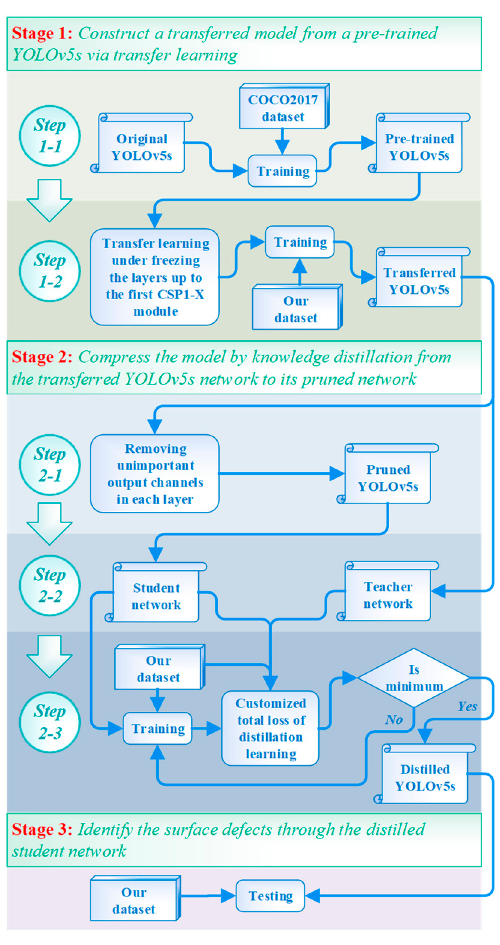
Figure 2. Proposed framework for identifying arc magnet surface defects. (1) Stage 1 : Construct a transferred model from a pre-trained YOLOv5s via trans- fer